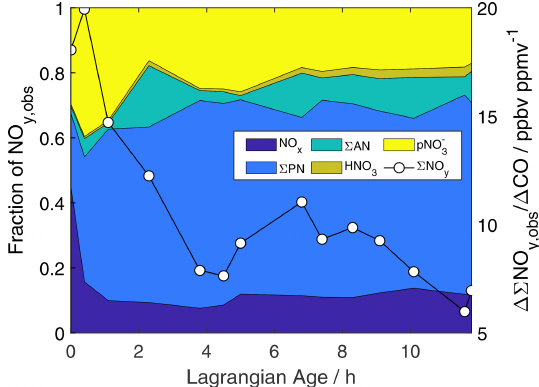
Figure 3. Age evolution of observed NO y speciation (solid colors; left axis) and the (cid:54) NO y, obs NEMR (white circles/line; right axis). (cid:54) NO y, obs is the bottom-up sum of observed NO y . (cid:54) PN represents tunable diode laser-induced fluorescence (TDLIF)